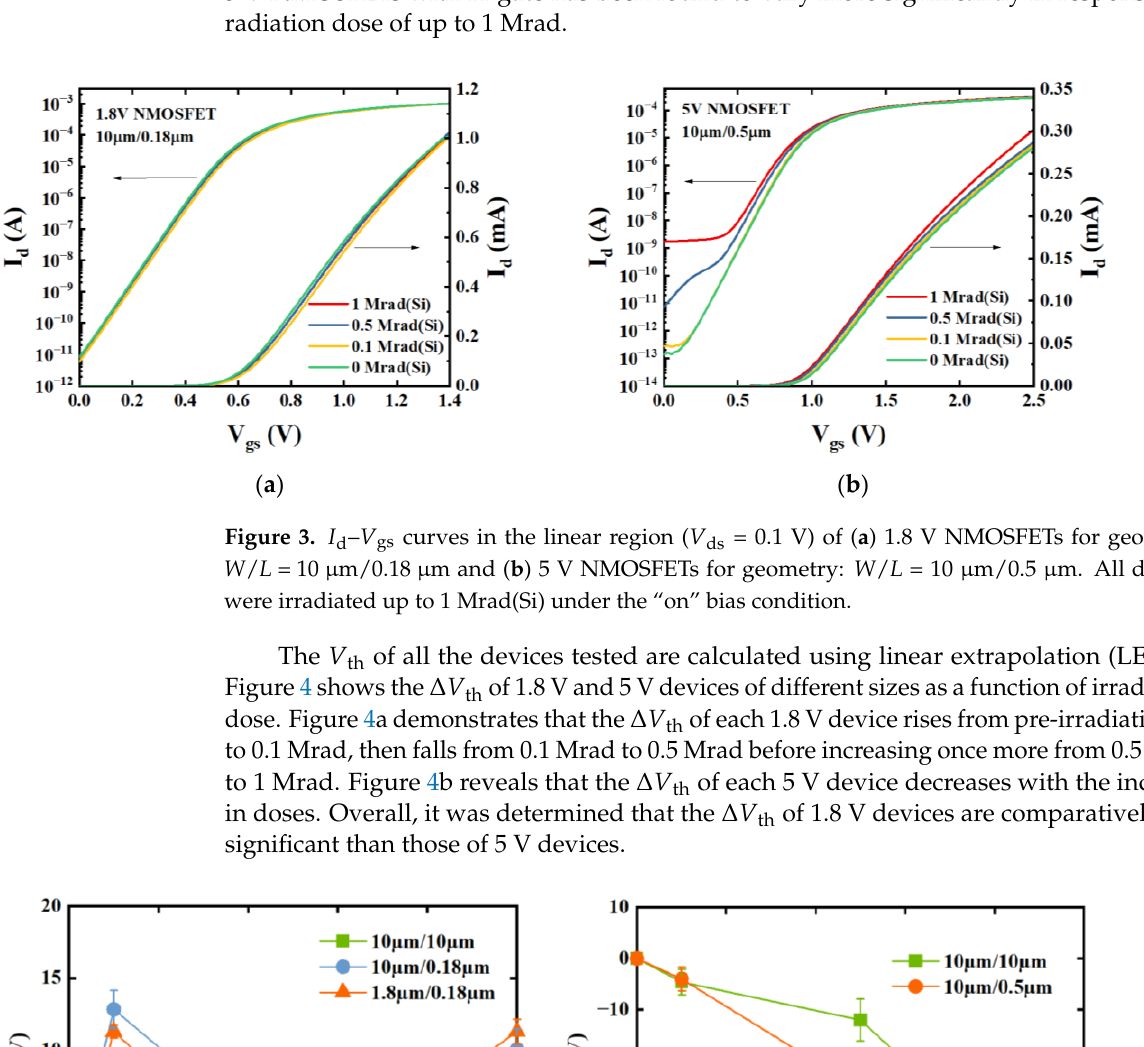
Figure 2. Illustration of the low-frequency noise measurement system.